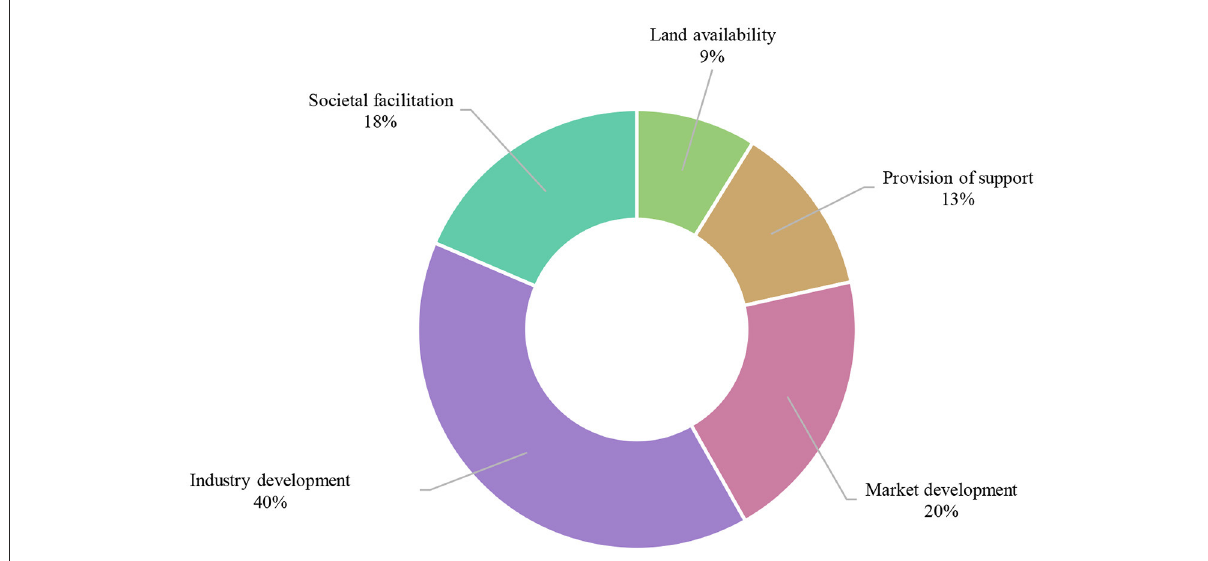
FIGURE5 Egg producers’ most frequently proposed solutions to the barriers preventing cage farmers from using cage-free systems.